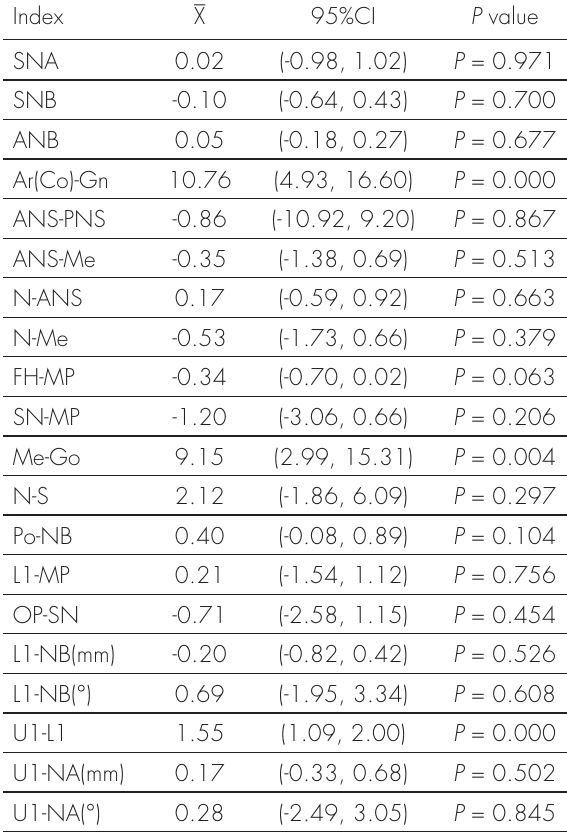
Table IV. Original